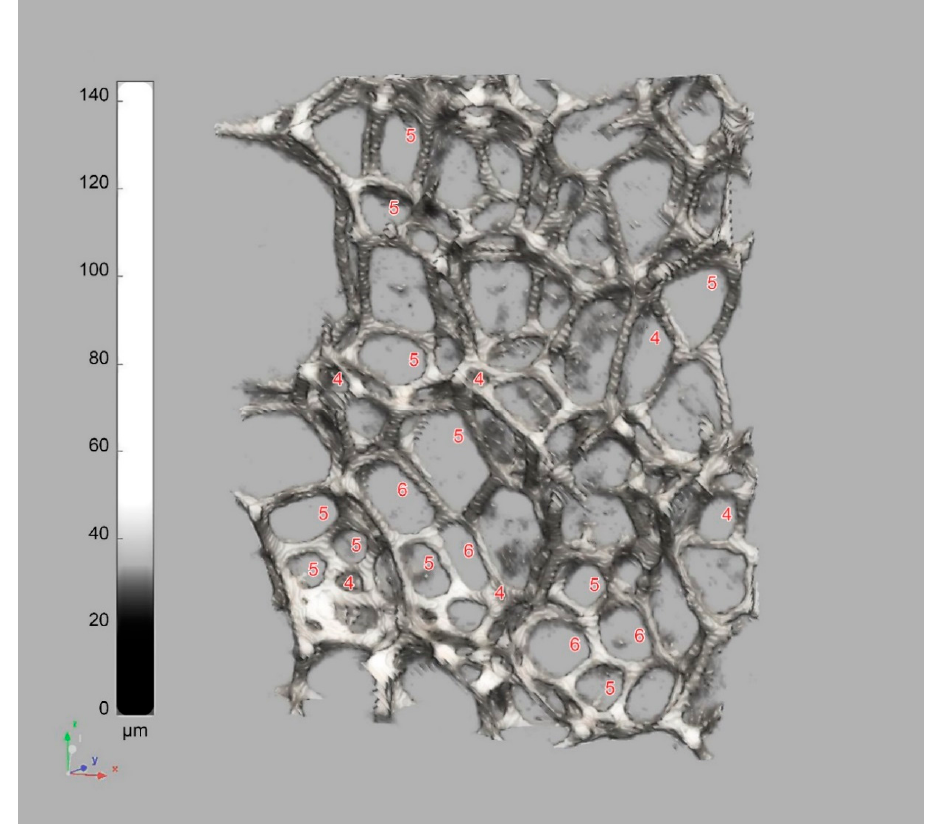
Figure 7. The PU foam microstructure, a cutout from the reconstructed W ‐ foam sample (µ ‐ CT resolution 6.25µm). The cell faces are labeled with numbers of their edges. The greyscale corresponds to strut thickness.